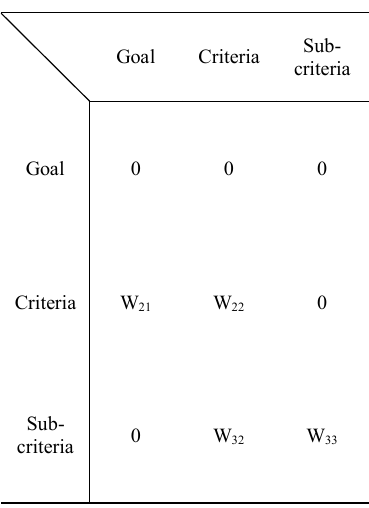
Table 4: Structure of the primary unweighted matrix in the network model to estimate the spatial potential of flooding based on the